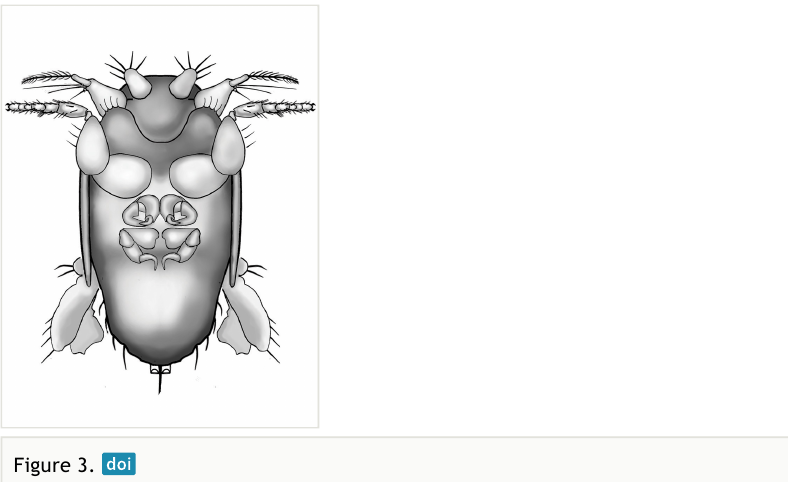
Figure 3. Megapropodiphora arnoldi sp. n. , female, ventral view. Legs re-arranged for easier viewing. Structure of mid- and hind legs approximate. Drawing by T. Hayden.